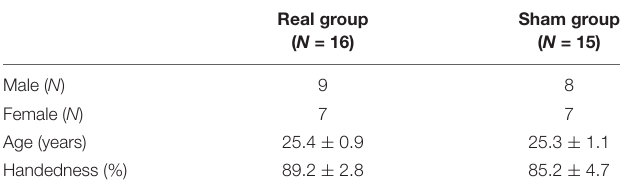
TABLE 1 | Baseline subject